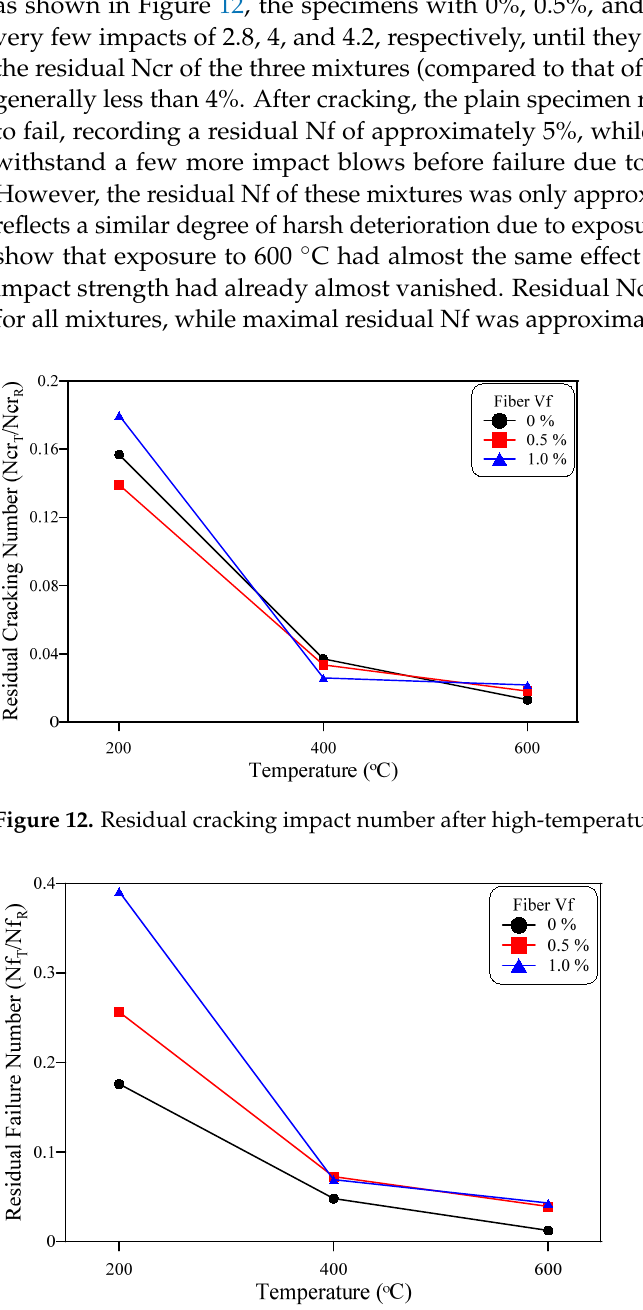
Figure 13. Residual failure impact number after high-temperature exposure.